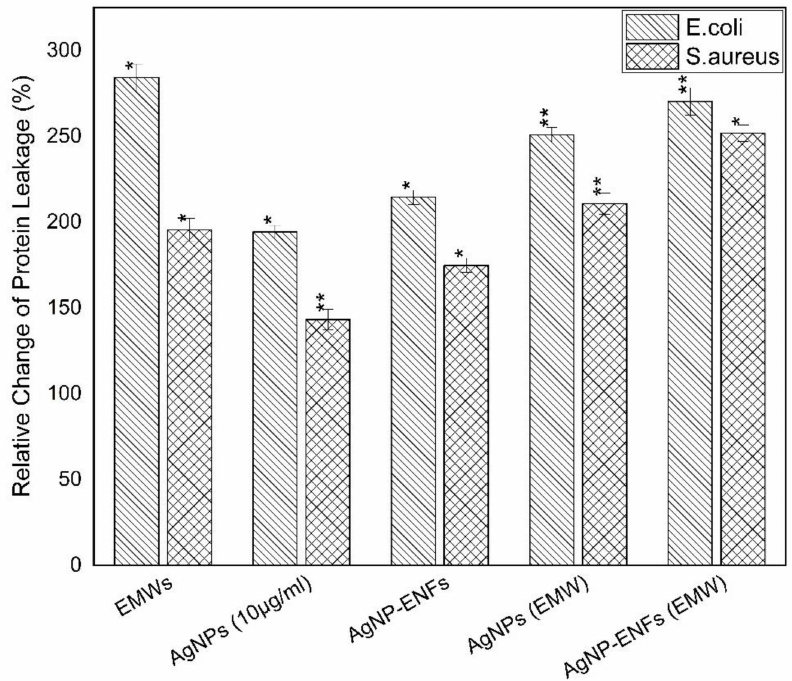
Figure 11. Relative change percentage in protein leakage for E. coli and S. aureus samples treated by Ag NPs, Ag NPs-ENFs, and EMWs; * statistically significant, ** statistically highly